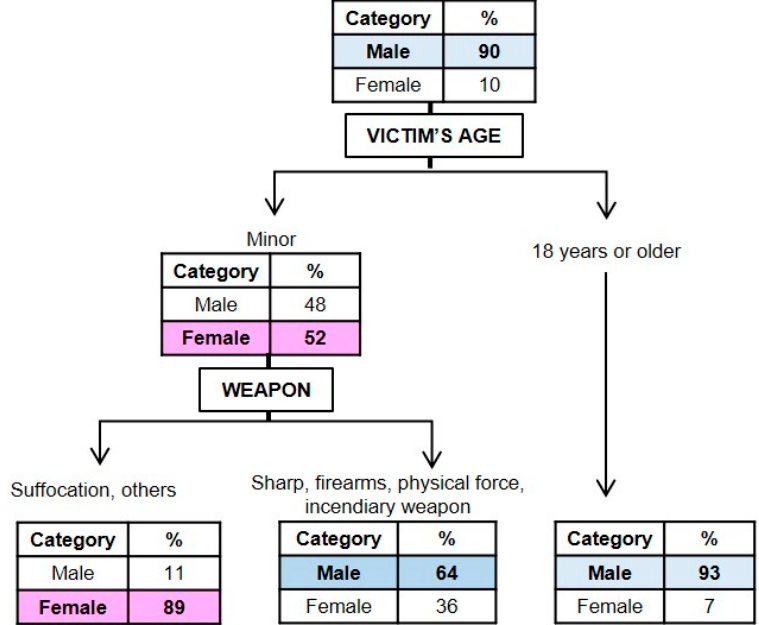
Figure 1. Graphical representation of the classification tree for the perpetrator’s gender.